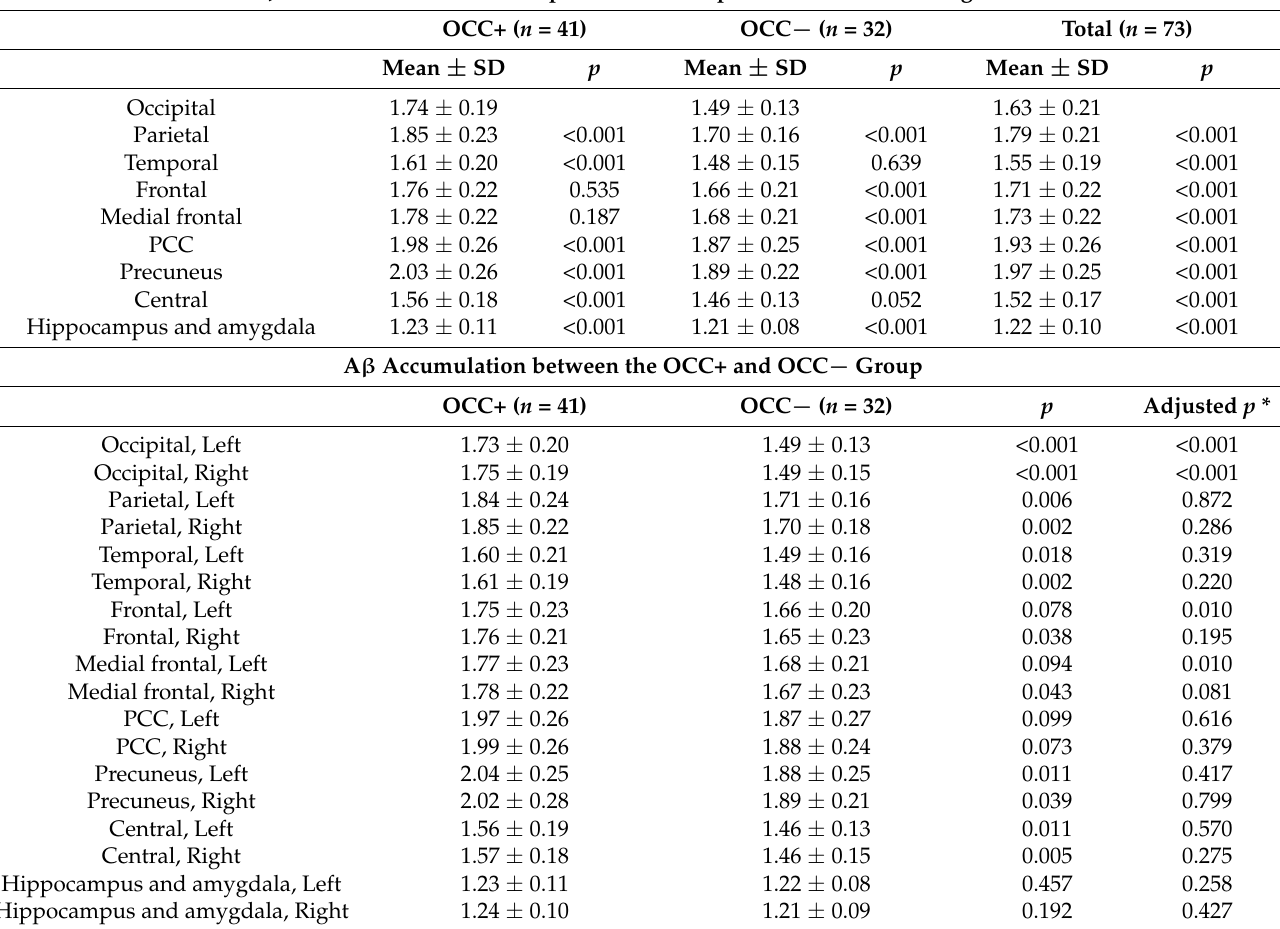
Table 2. Quantitative [18F]-Florbetaben amyloid PET analysis in the occipital lobes. A β Accumulation in the Occipital Lobes Compared to Other Brain